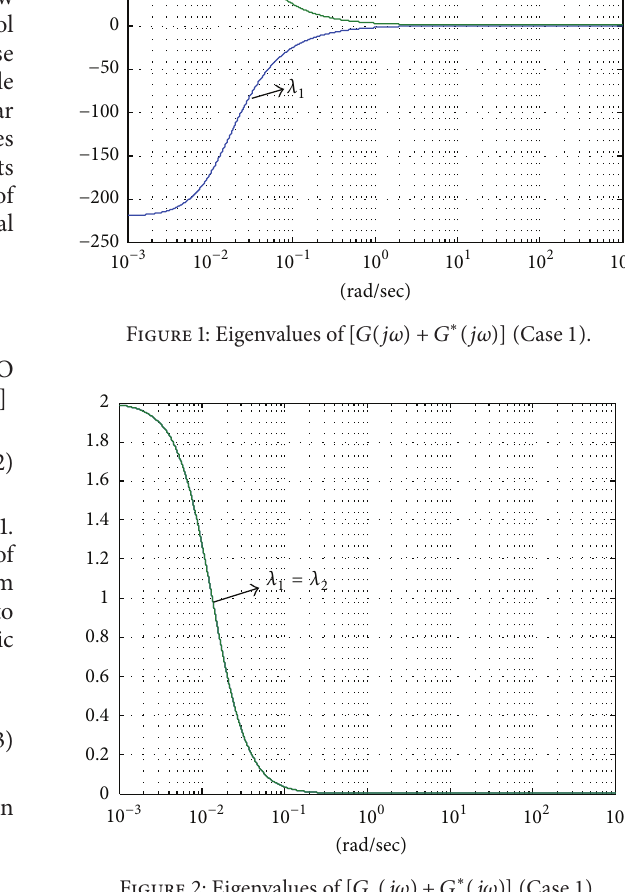
Figure 2: Eigenvalues of [𝐺 𝑝 (𝑗𝜔) + 𝐺 ∗ 𝑝 (𝑗𝜔)] (Case 1